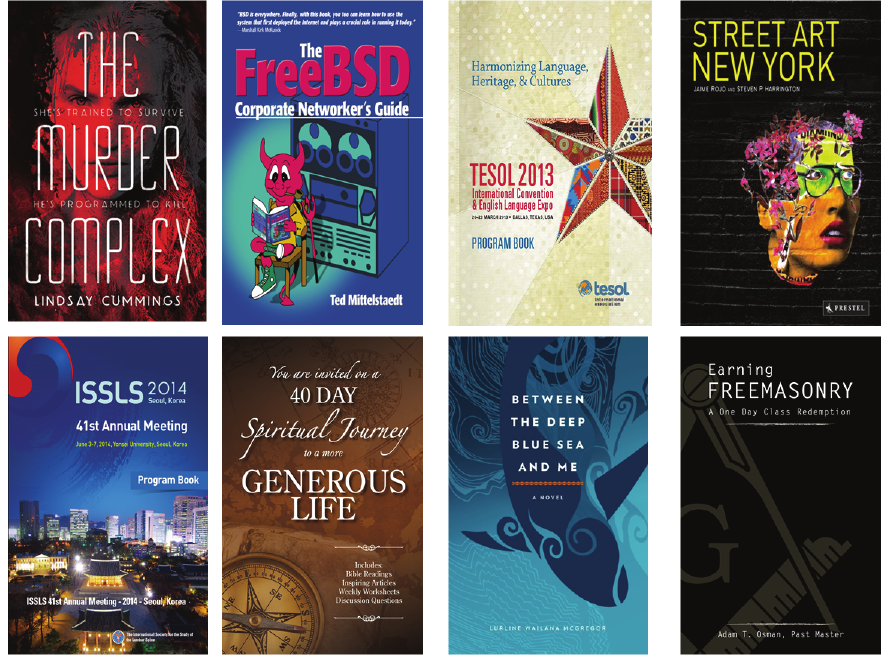
Figure 6: Sample images in test dataset